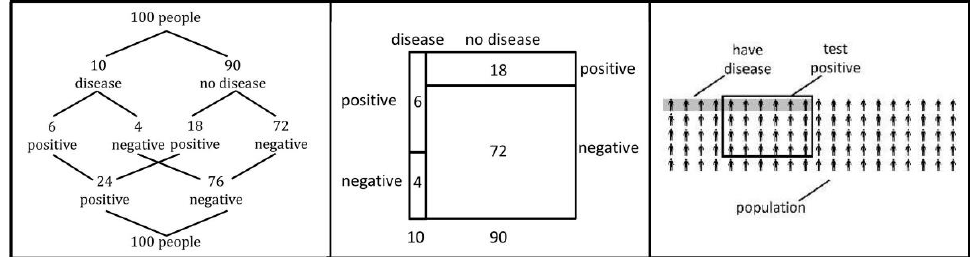
Figure 1. Double tree diagram, unit square and icon array as visualizations of a Bayesian situation.